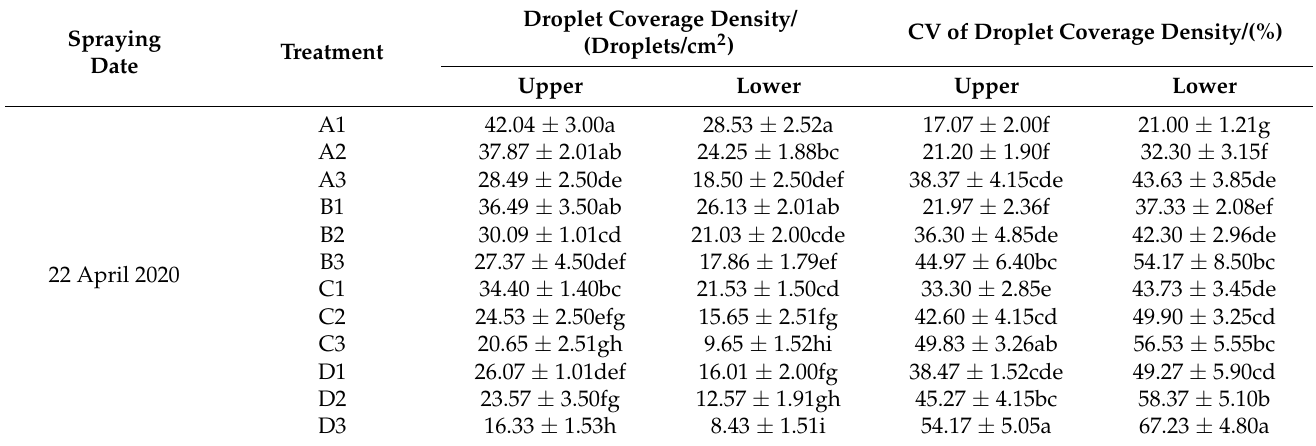
Table 5. Aphid distribution on wheat plants.